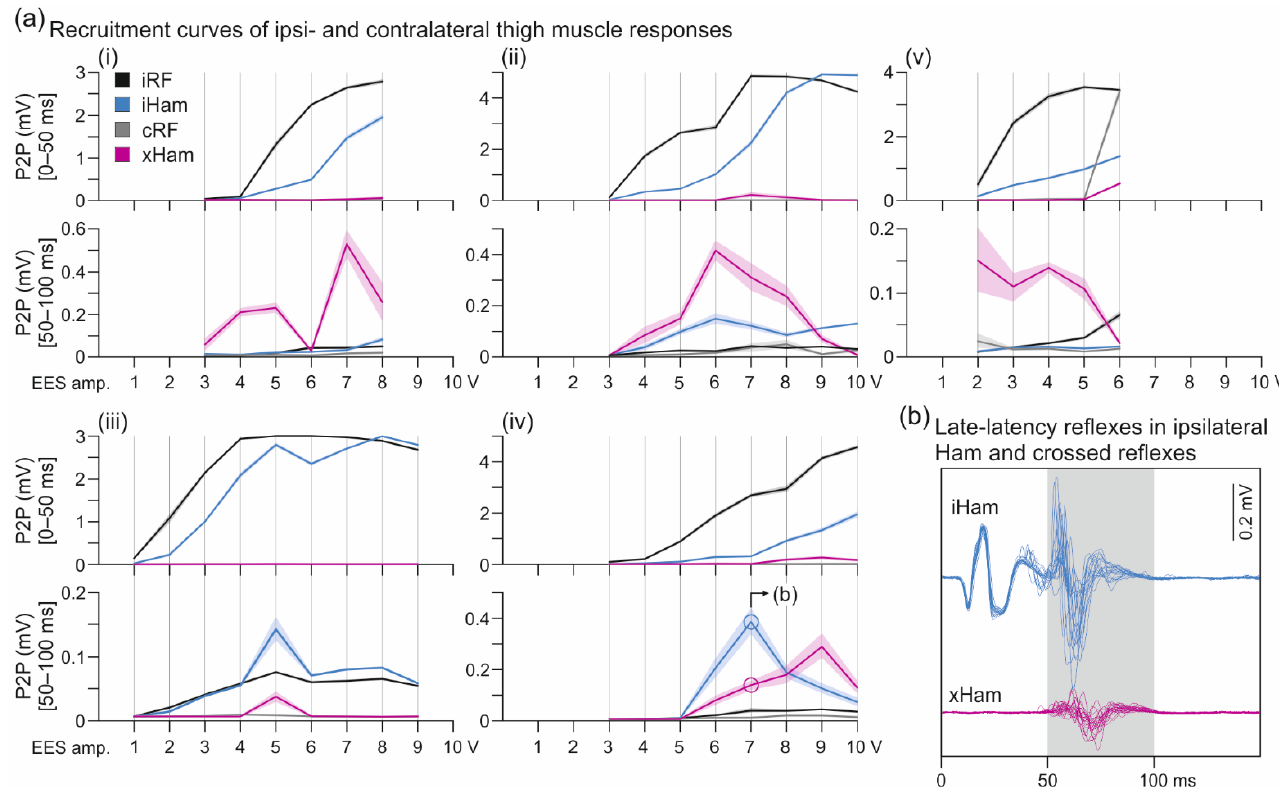
Figure 3. Recruitment of ipsi ‐ and contralateral responses with graded unilateral EES at ~6 Hz. ( a ) Recruitment curves of monosynaptic posterior root ‐ muscle reflexes of rectus femoris (RF) and the hamstrings muscle group (Ham; analysis time window: 0–50 ms post ‐ stimulus) and of crossed reflexes (50–100 ms). All five observed cases shown in individual panels; ( i ) recording 1, right ‐ sided EES; ( ii ) recording 2, left ‐ sided EES; ( iii ) recording 3, left ‐ sided EES; ( iv ) recording 3, right ‐ sided EES; all subject 4; ( v ) recording 1, right ‐ sided EES, subject 7. EMG analysis within the 50–100 ms time window identified late ‐ latency responses in the ipsilateral Ham in subject 4, shown in ( b ) for recording 3, right ‐ sided EES, 7 V. amp., amplitude; c, contralateral; EES, epidural electrical stimulation; i, ipsilateral; P2P, peak ‐ to ‐ peak EMG amplitude; x, crossed reflex.